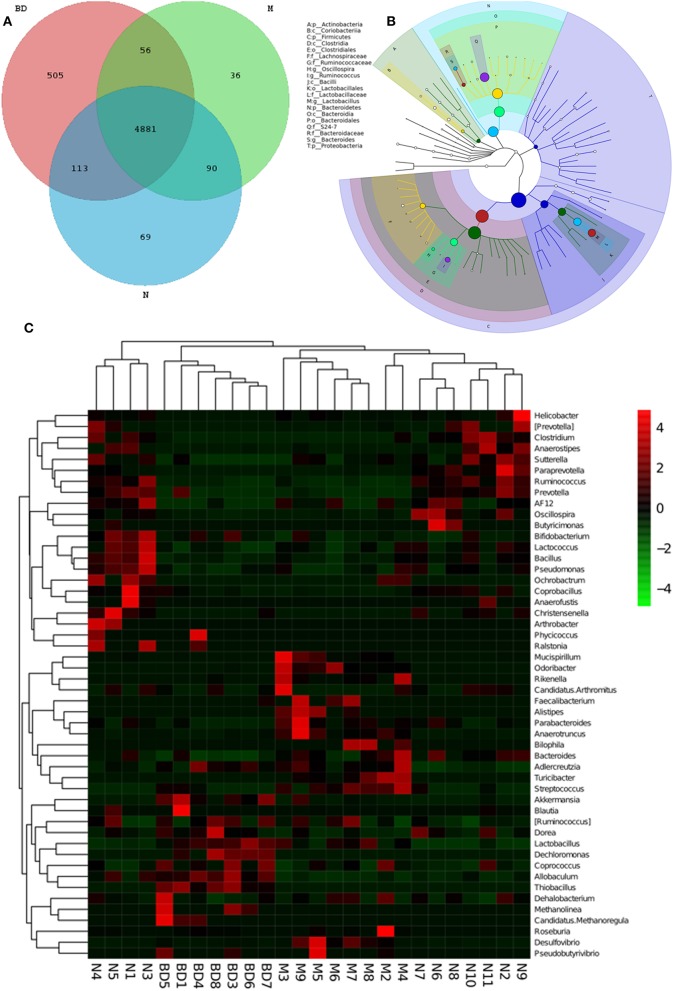
Effects of OMO on the microbiota in fecal samples from the APP/PS1 transgenic mice. A Venn diagram of OTUs (A), a sample species classification tree (B), and the heatmap of 16S rRNA gene sequencing analysis of fecal contents at the genus level (C) are shown. N denotes the control group, M denotes the APP/PS1 transgenic group, and BD designates the 50 mg/kg OMO-treated group.